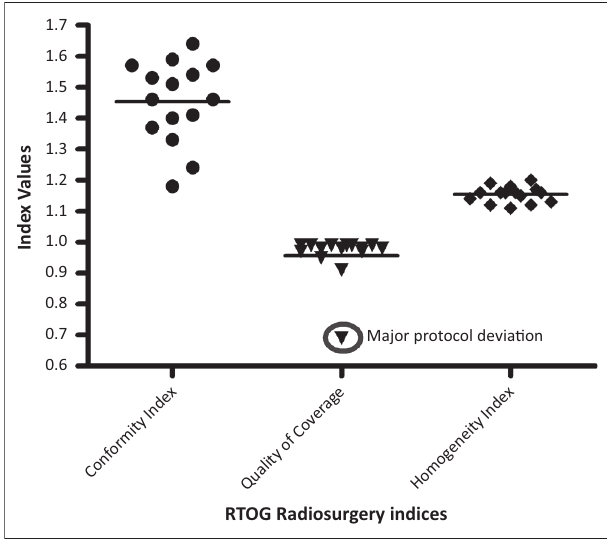
FIGURE 3: Paddick gradient index comparison between the Groote Schuur Hospital dynamic conformal arc technique and published results from Universitair Ziekenhuis Brussel for CyberKnife, Novalis intensity modulated radiotherapy, Novalis DCA and Perfexion GK techniques. 15